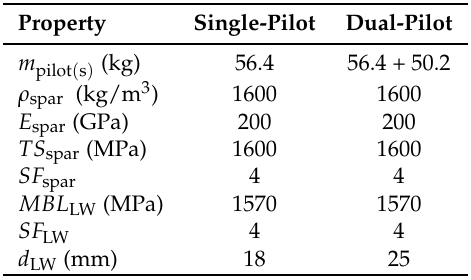
Table 4. Structural properties of the spar and lift wire.